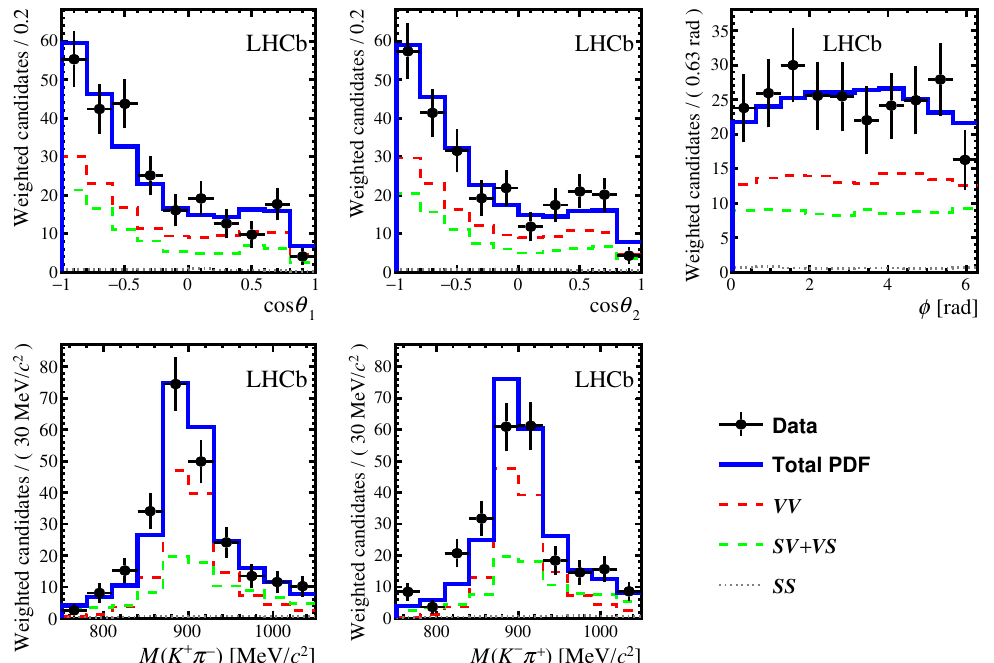
Figure 4 . Projections of the amplitude (cid:12)t results for the B 0 K (cid:3) 0 K (cid:3) 0 decay mode on the helicity ! angles (top row: cos (cid:18) 1 left, cos (cid:18) 2 centre and (cid:30) right) and on the two-body invariant masses (bottom row: M ( K + (cid:25) (cid:0) ) left and M ( K (cid:0) (cid:25) + ) centre). The contributing partial waves: V V (dashed red), V S (dashed green) and SS (dotted grey) are shown with lines. The black points correspond to data and the overall (cid:12)t is represented by the blue line.